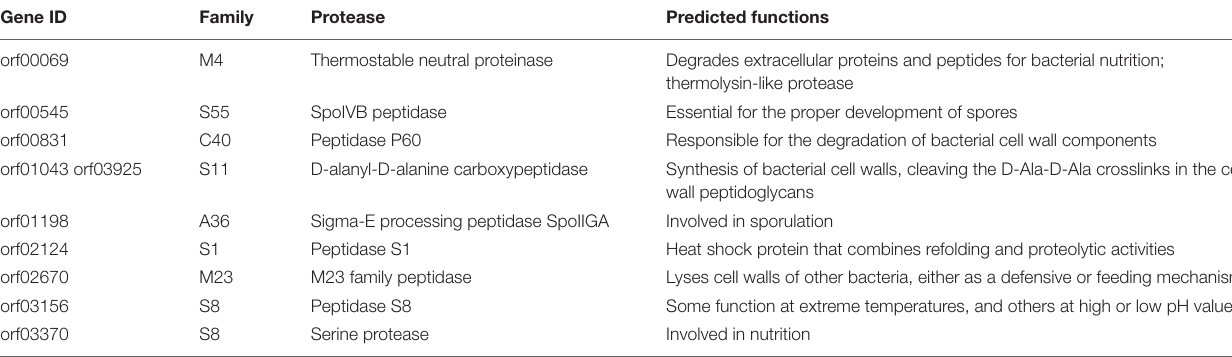
TABLE 3 | The extracellular proteases of strain 1A02591 predicted by genome sequencing and gene annotation.